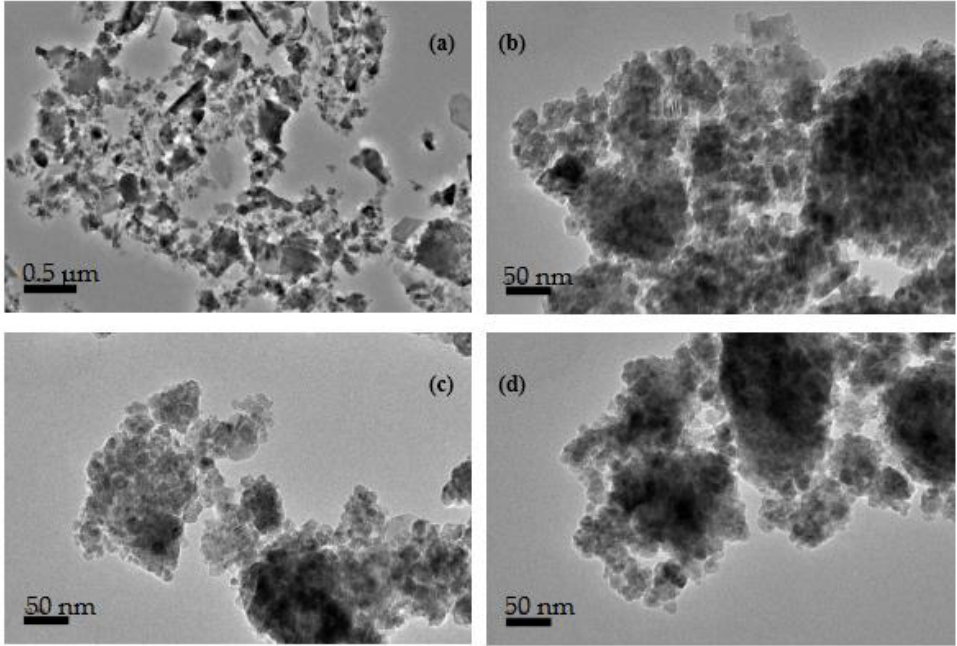
Figure 6. HRTEM micrographs of recycled α -Fe 2 O 3 at ( a ) 0 h, ( b ) 8 h, ( c ) 10 h, and ( d ) 12 h.